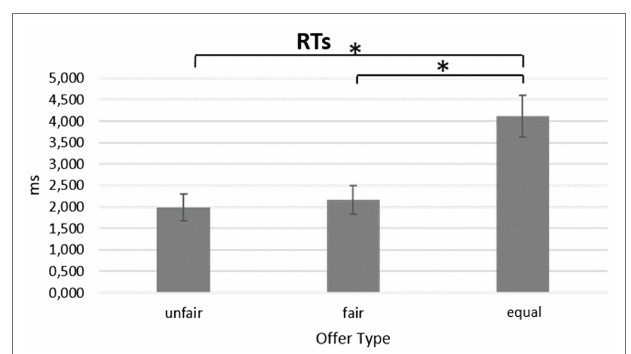
FIGURE 4 | Reaction Times. Bar chart shows higher AR of equal compared to fair offers in the EXP group. Bars represent ±1 SE; all asterisks mark statistically significant differences, with p ≤